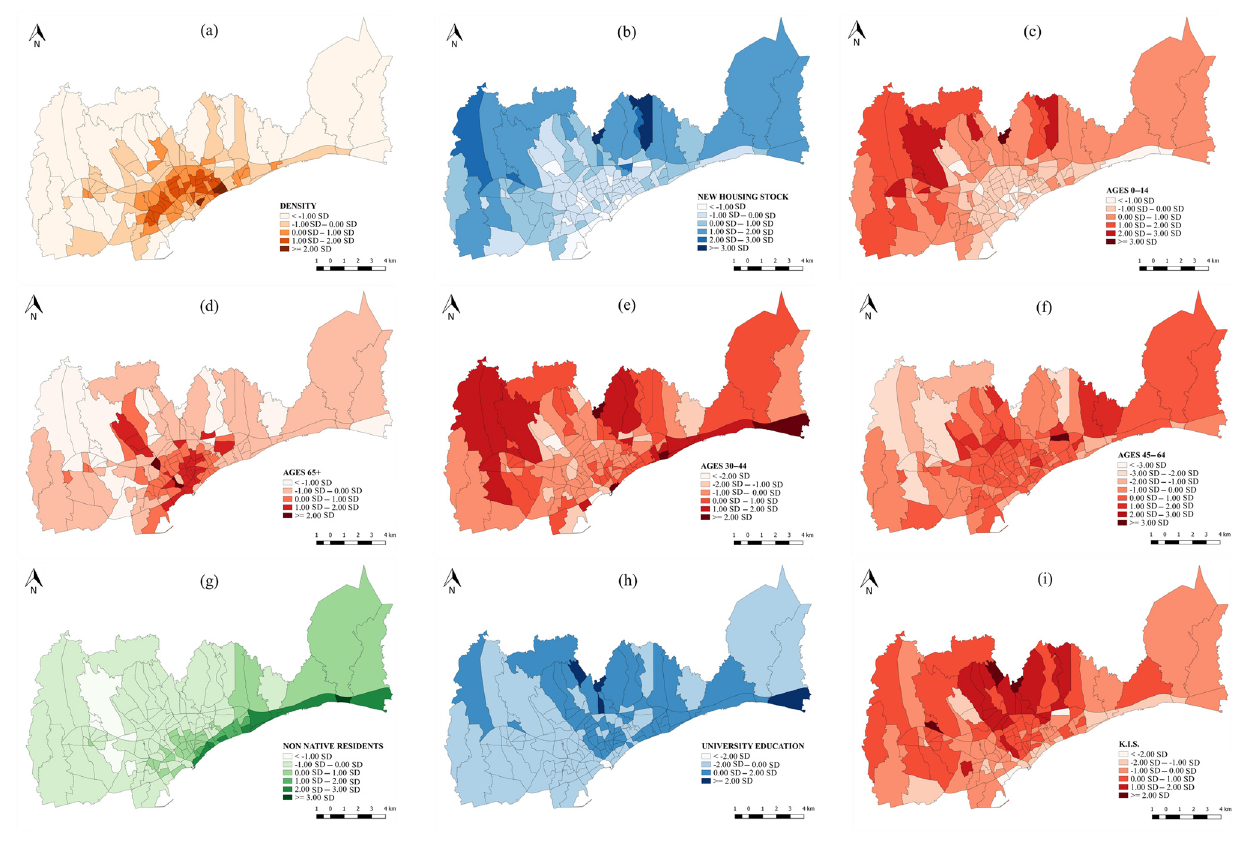
Figure 5. Study area characteristics. (a) density; (b) new housing stock; (c) ages 0–14; (d) ages 65 + ; (e) ages 30–44; (f) ages 45–64; (g) no- native residents; (h) university education; (i) employed in creative industry. Source: CYSTAT, population census 2011, own